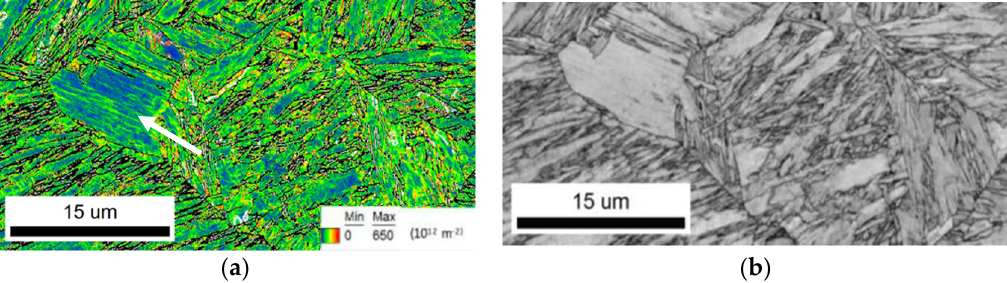
Figure 3. EBSD ( a ) Geometrically Necessary Dislocation (GND) density and ( b ) Image quality map of Sample 2. The GNDs were calculated for a maximum angle of 10° and up to the 3rd neighbour pixel.